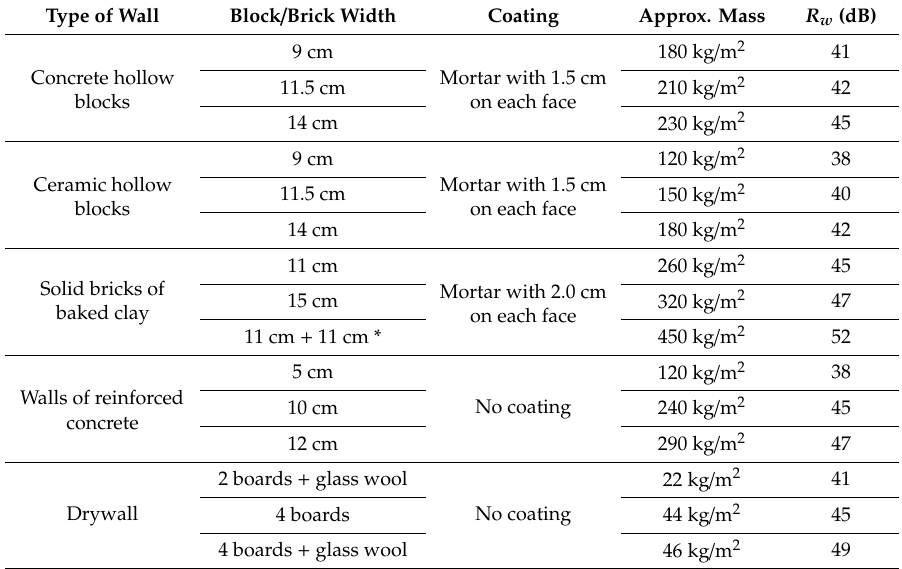
Table 13. Indicative values of weighted sound reduction index for some wall systems.